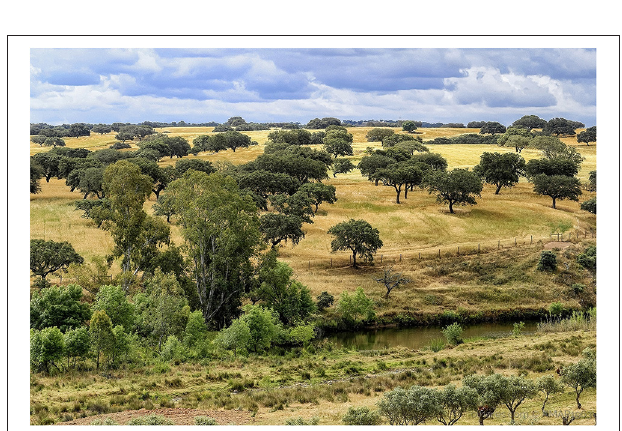
FIGURE 2 | Open and low-density montado fields with undercover pasture, dominating a landscape mosaic of semi-natural and cultivated land-uses.